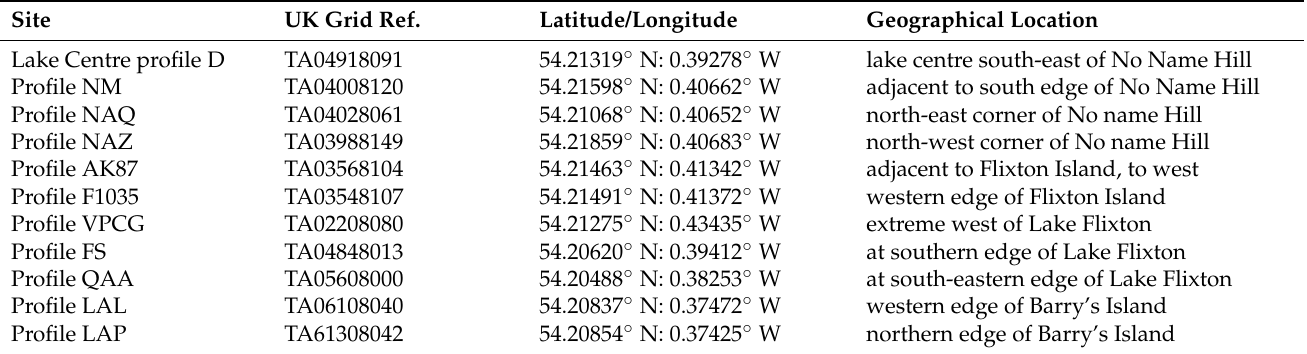
Table 1. Details of the new pollen sites presented in this paper and located in Figure